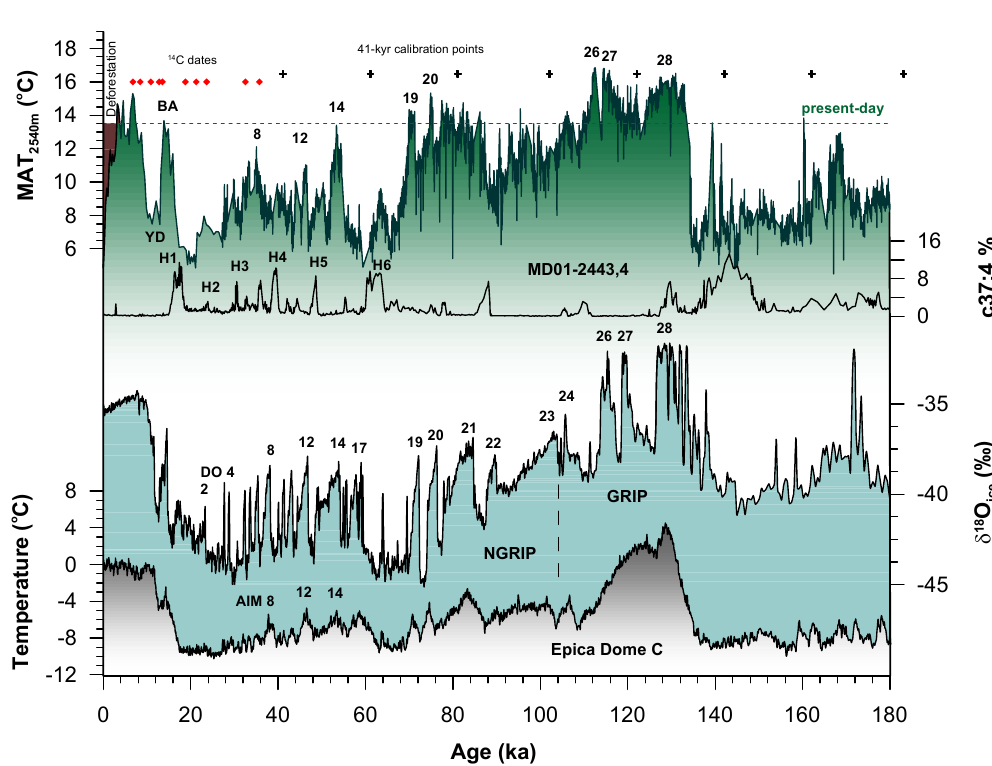
Fig. 8. Comparison between the reconstructed mean annual temperatures (MAT) at Lake F´uquene and the combined Greenland δ 18 O ice core records for the past 180000 years (GRIP-Members, 1993) and temperature record of Epica Dome C (Jouzel et al., 2007; Parrenin et al., 2007). The DO numbers indicate Dansgaard-Oeschger cycles and AIM are the Antarctic Isotope Maxima (AIM). H1-H6 corresponds to the Heinrich events. BA= Bølling-Allerød interstadial and YD=Younger Dryas. The combined Greenland δ 18 O record includes (1) the Greenland Ice Core Chronology 2005 (GICC05) (NGRIP Members, 2004) based on annual layer counting for the past 60ka, (2) the original NGRIP data (NGRIP Members, 2004; Svensson et al., 2008) between 60 and 103ka, and (3) the data of GRIP below